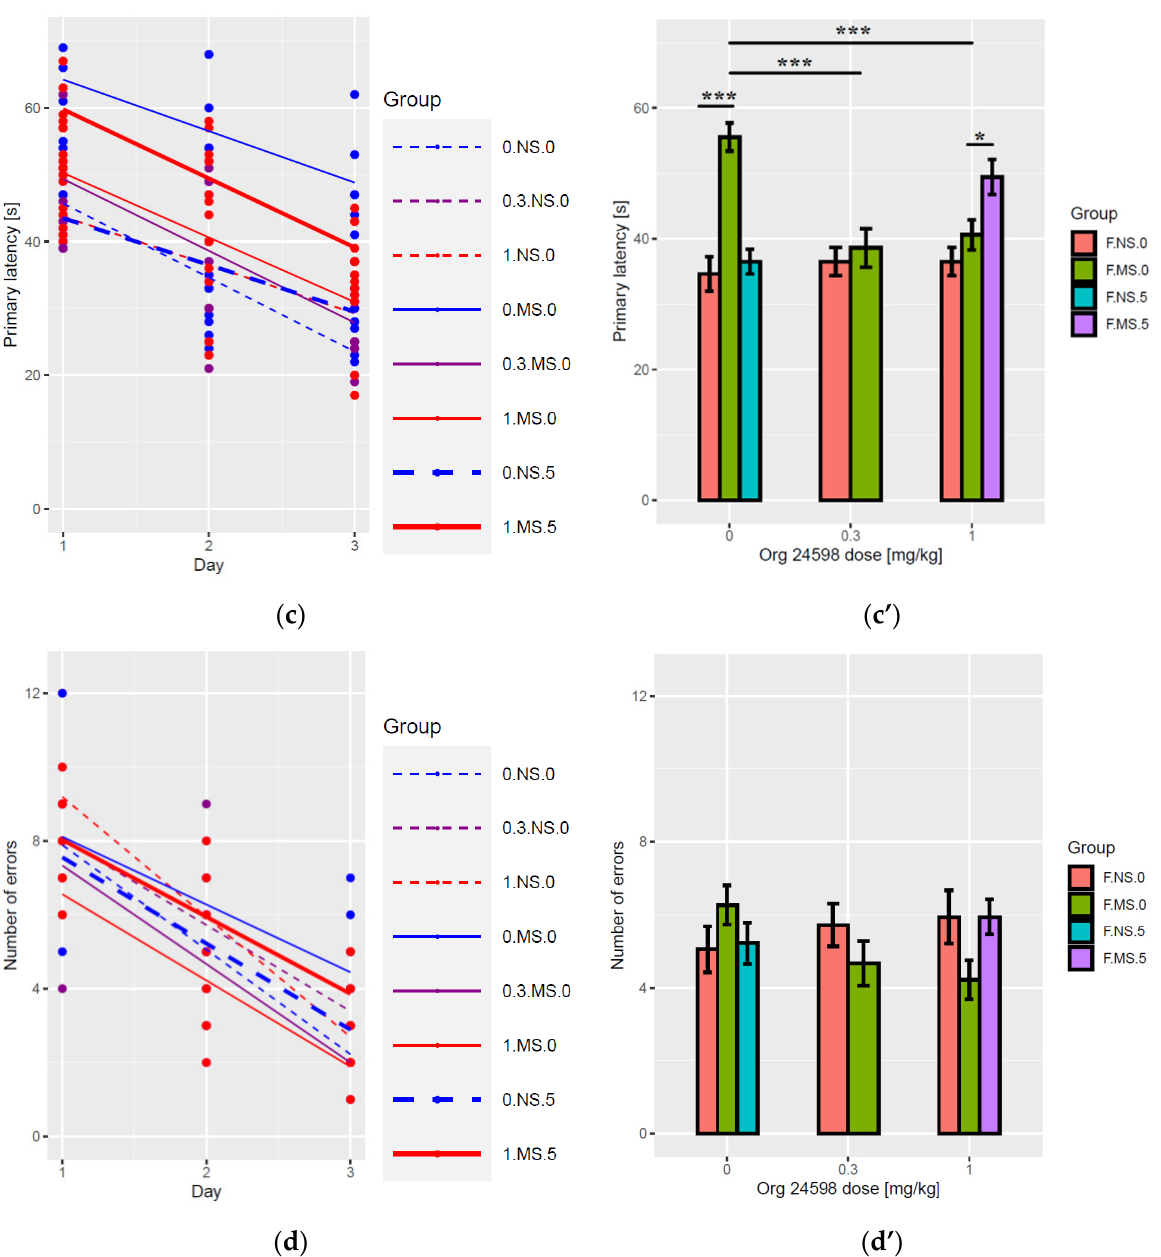
Figure 2. Effect of Org 24598 (0.3 mg/kg and 1.0 mg/kg) or vehicle on the primary latency for males ( a , a’ ) and females ( c , c’ ) and number of errors for males ( b , b’ ) and females ( d , d’ ) committed during 3 days of the reversal learning phase of the Barnes maze task in adolescent (PND35-37) Wistar rats ( n = 6) subject to MS for 180 min during PND1-21. Left and right panels show the same results, in linear and bar plots. For statistics, see the Results section. PND—postnatal day; MS—maternal separation; NS—non-separated; 0.3—Org 24598 at the dose of 0.3 mg/kg; 1—Org 24598 at the dose of 1.0 mg/kg; 5—L-701,324 at the dose of 5 mg/kg. The bar plots show the average primary latency and number of errors committed over three days of the reversal learning phase of the Barnes maze. * p < 0.05; *** p < 0.001 vs. non-separated.